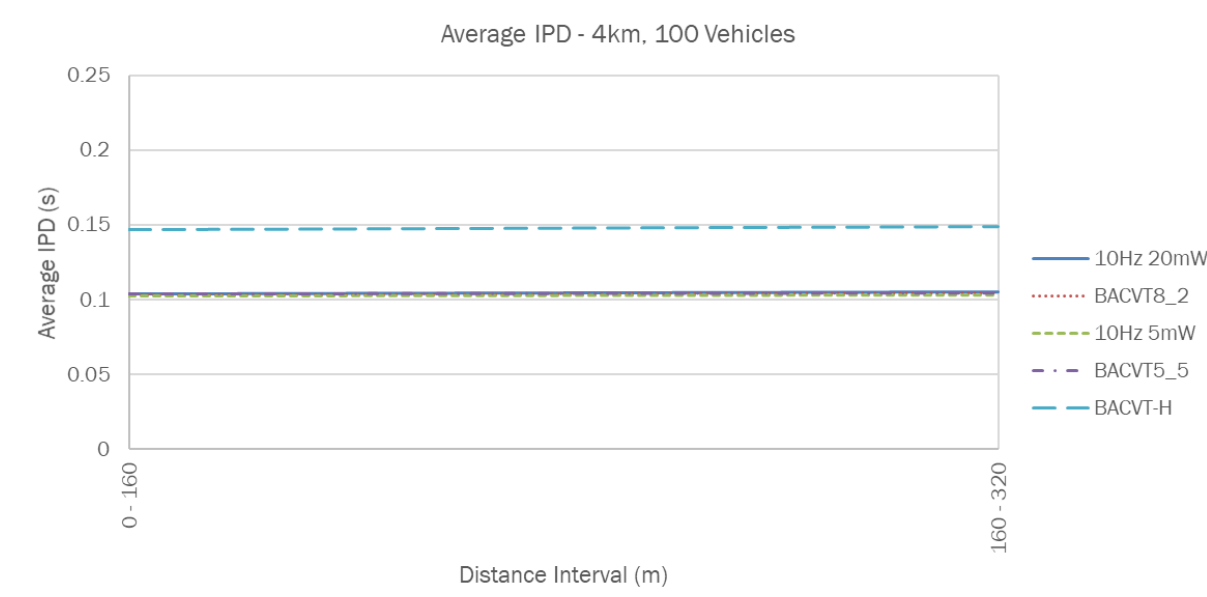
Figure 9. IPD in low vehicle